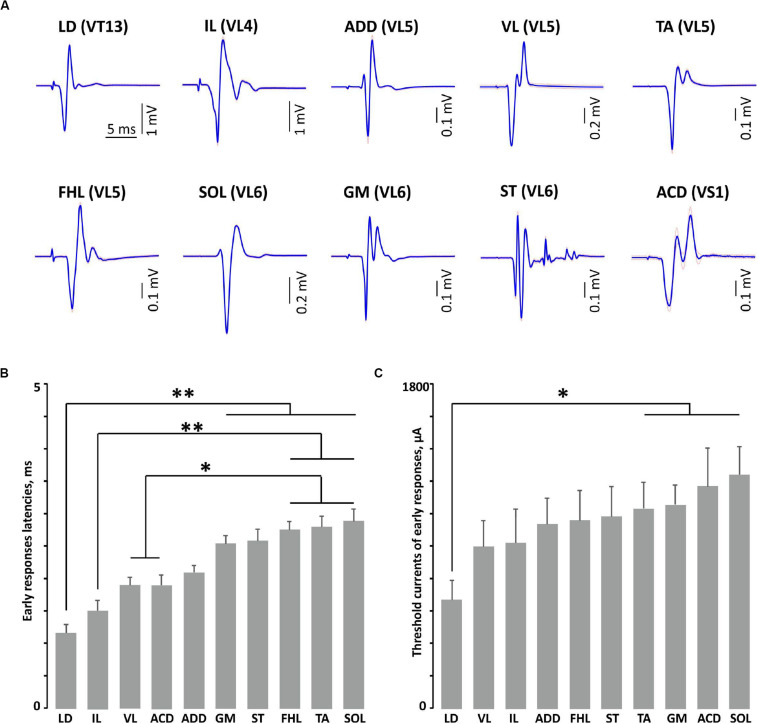
The examples of averaged evoked potentials (SE plotted by dotted line) (A) and the latencies (B) and threshold currents (C) of early responses of mm. longissimus dorsi (LD), abductor caudae dorsalis (ACD), iliacus (IL), adductor magnus (ADD), vastus lateralis (VL), semitendinosus (ST), tibialis anterior (TA), gastrocnemius medialis (GM), soleus (SOL), and flexor hallucis longus (FHL) at maximal or submaximal current at “optimal” stimulation. **p < 0.01, *p < 0.05.